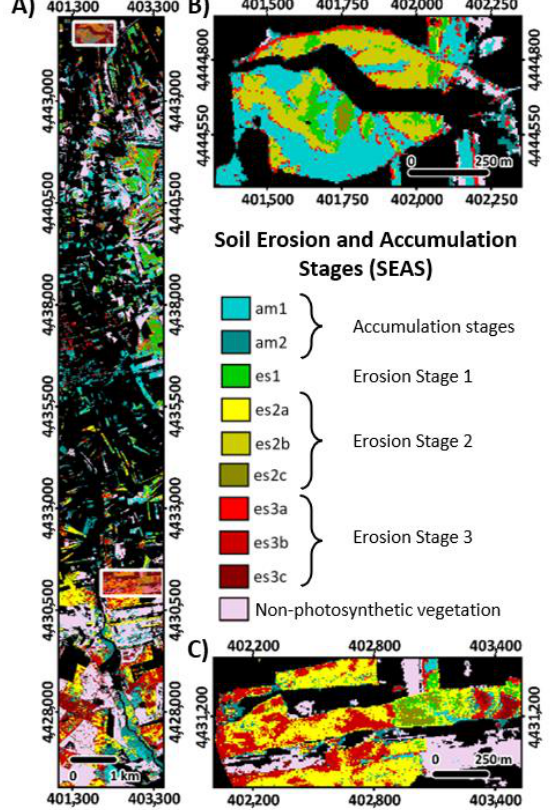
Figure 4. ( A ) Mapping of SEAS modified based on Schmid et al. (2016) [19] and highlight of ( B ) northern and ( C ) southern crop field sites of interest.